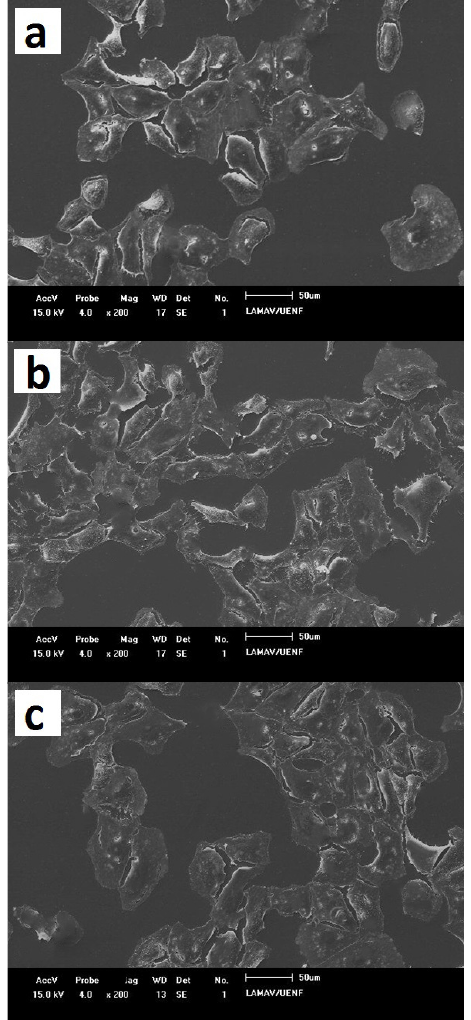
Figure 7 - Electron micrographs of Vero cells after 24 hours culture. Control group ( a ), in medium with Ti ( b ) and Ti-2D ( c ), observed in 200x